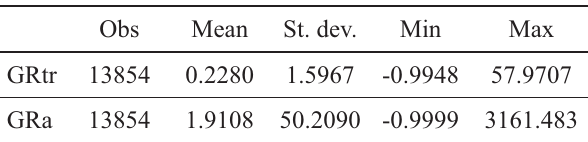
Table 1. Descriptive statistics of growth of sales (GRtr) and growth of assets